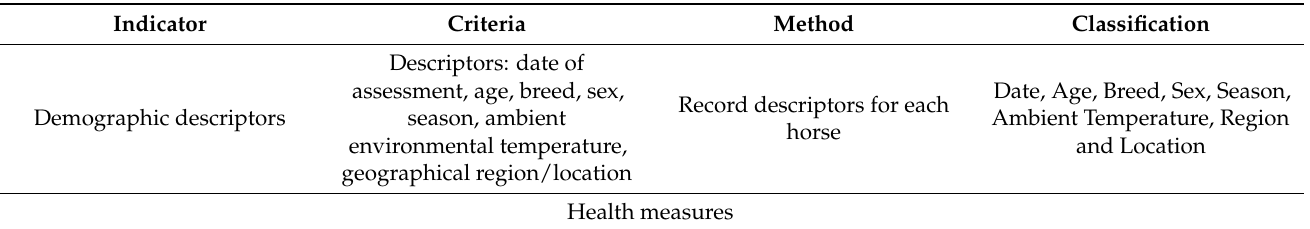
Table 2. Welfare assessment protocol, including indicators, criteria of use, method of use and